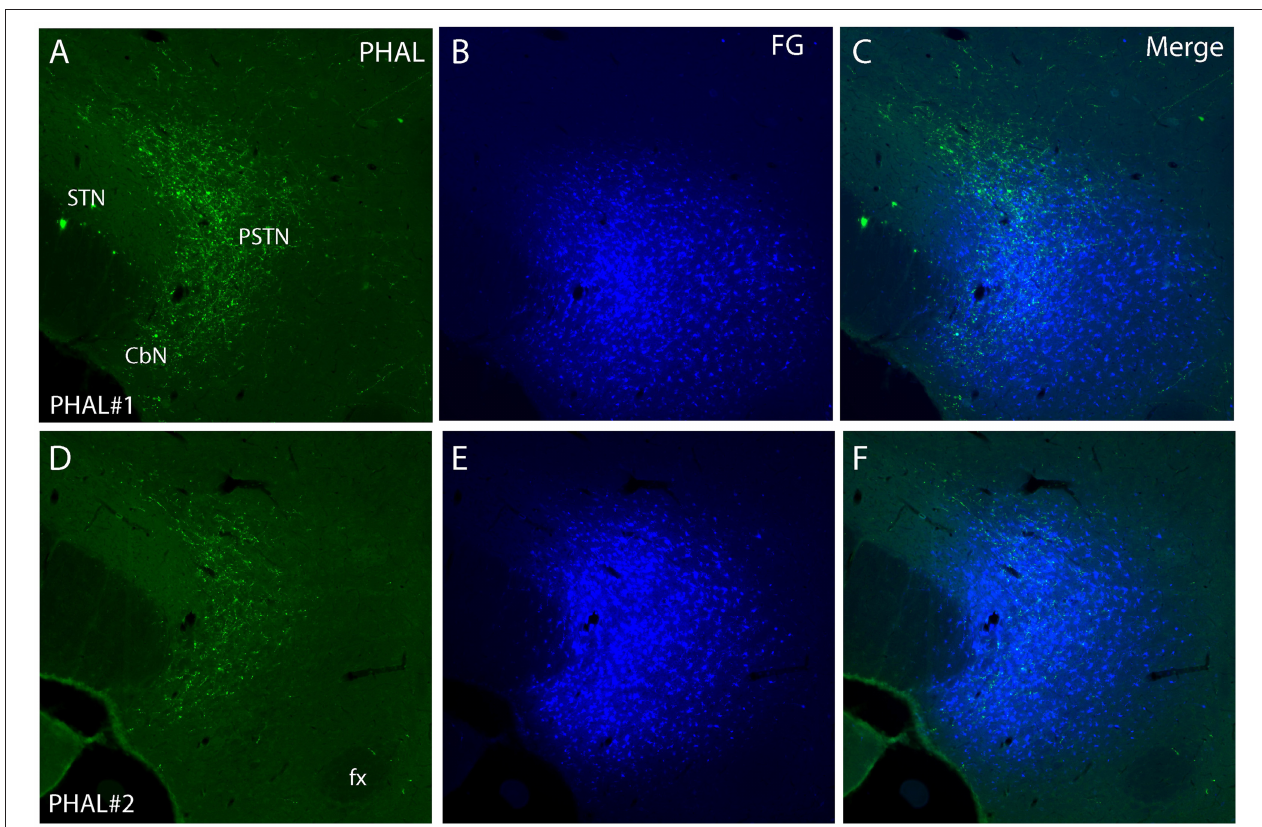
FIGURE 4 | Photomicrographs of PHAL (A, D) and FG (B, E) dual labeling in fluorescence in experiments PHAL#1 and PHAL#2. Note the innervation of the PSTN region, adjacent to the STN, by PHAL axons. The innervation in experiment PHAL#1 is however more intense than in experiment PHAL#2. A FG injection was aimed at the PSTN in both experiments that slightly involved adjacent STN and LHA areas ( C, F Merge images from A, B and D, E